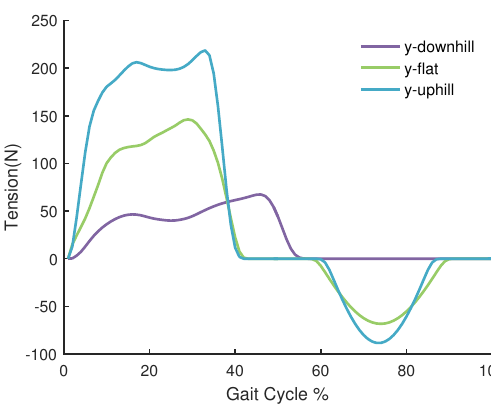
Figure 6. The tension in the Bowden cable at different times in the gait cycle on different slope ground. The positive force represents the force applied in the Knee Board to assist hip joint extension and knee joint extension and the negative force is the force at the front of the thigh, which produces an assistance force in hip joint